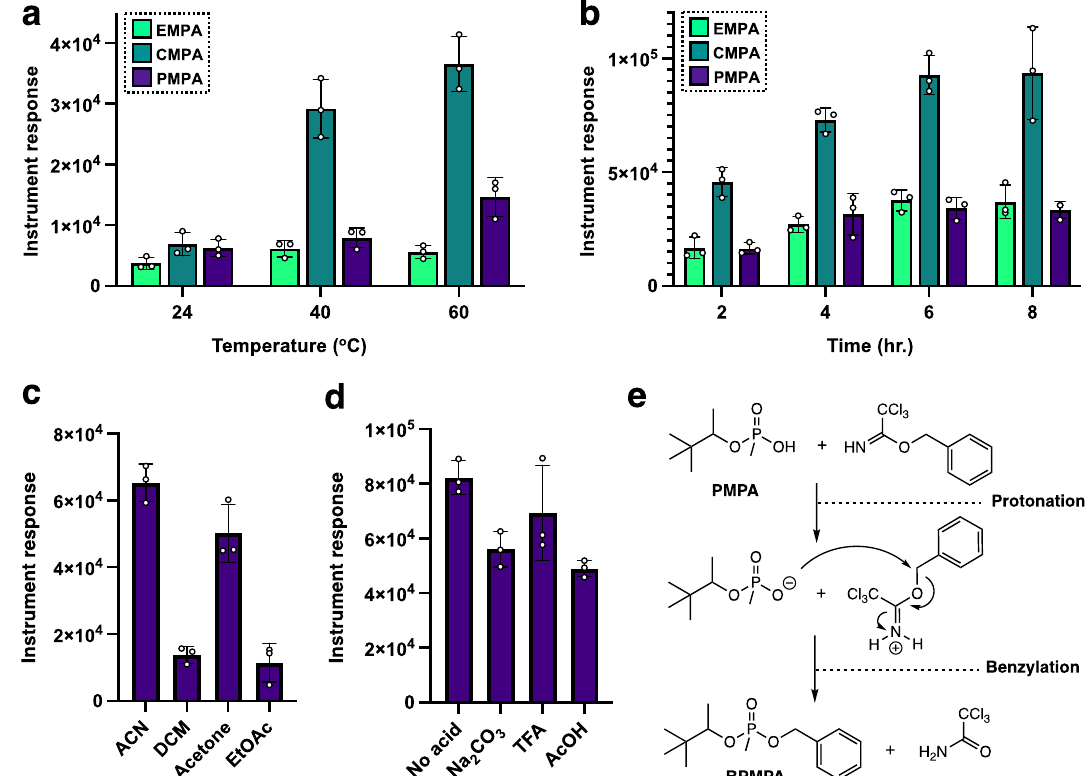
Figure 2. Optimization reactions, average (n = 3) peak areas (± the standard deviation) for the benzylated phosphonic acid after the acid (0.8 μmol, [100 ppm]) is treated with the trichloroacetimidate (200 μL, excess) in acetonitrile (ACN, 1 mL), that included ( a ) the effect of temperature on the derivatization yields similar results for mild heating (40 °C) and heating to 60 °C for 4 h; ( b ) time for the reaction where a maximum accumulation of the three benzylated products can be observed at ~ 4 h; ( c ) studies on just PMPA reveal that acetonitrile and acetone are optimal solvents for the derivatization over DCM and EtOAc; ( d ) effect of no additives (‘neutral’), base (20 mg, excess) and catalytic acid (TFA and AcOH, 0.08 μmol (10 mol% relative to phosphonic acid) on the reaction demonstrates that the reaction works well under all these conditions; ( e ) proposed mechanism